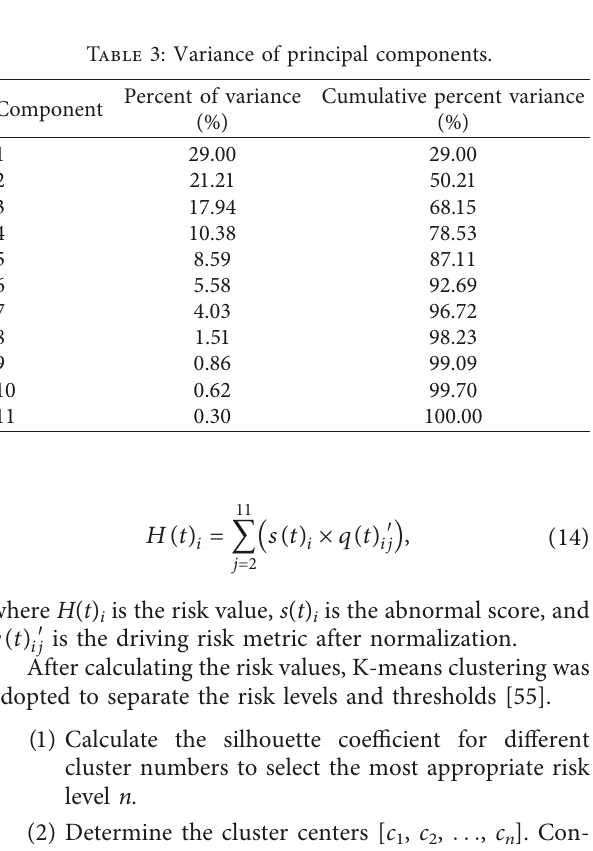
Figure 6: MIC of the variables.